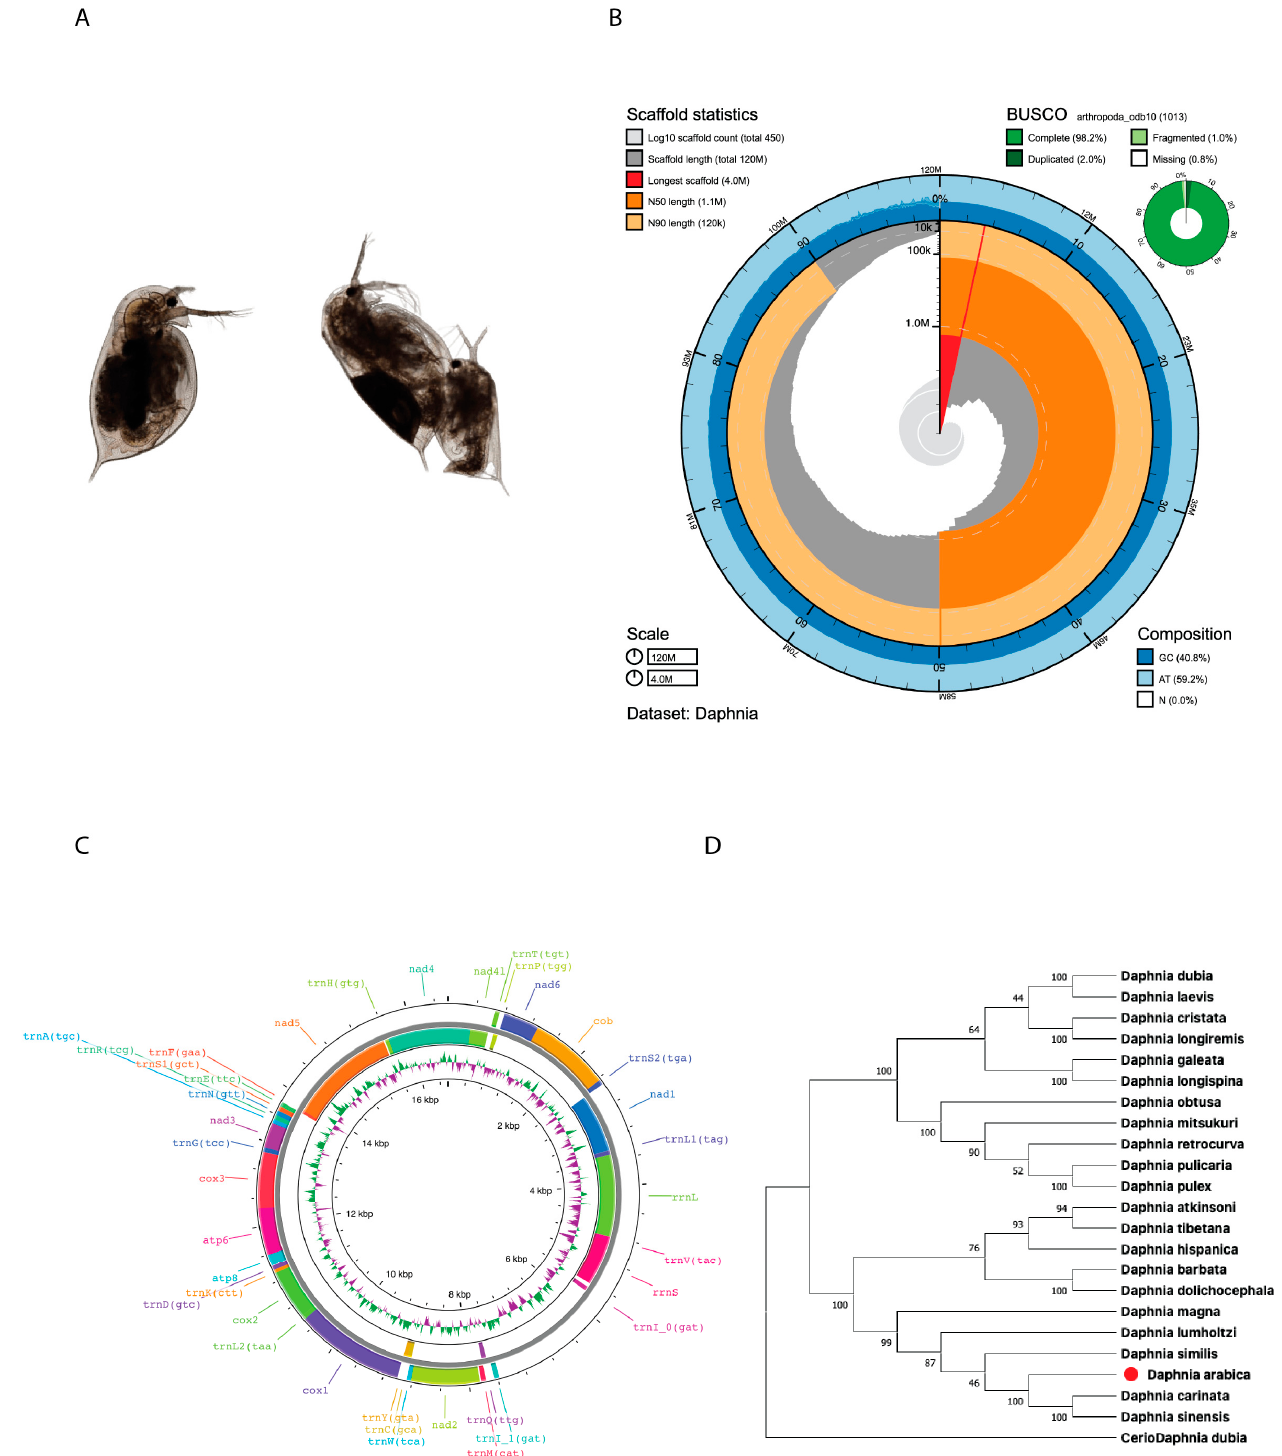
Figure 1. ( A ) General views of Daphnia arabica: parthenogenetic female and ephippial female and male at copulation. ( B ) D. arabica whole genome assembly statistics and assembly quality in snail plot view. ( C ) D. arabica mitogenome map. ( D ) Mitogenome based phylogenetic tree of D. arabica .